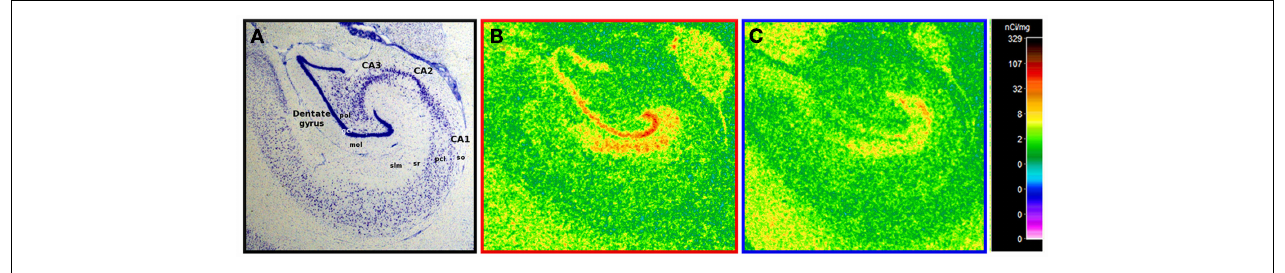
[ 3 H]citalopram binding following chronic ethanol self-administration. Note that lower binding is visually apparent in the ethanol drinker. Abbreviations: gcl, granule cell layer; mol, molecular layer; pcl, pyramidal cell layer; pol, polymorphic layer; slm, stratum lacunosum moleculare; so, stratum oriens; sr, stratum radiatum.